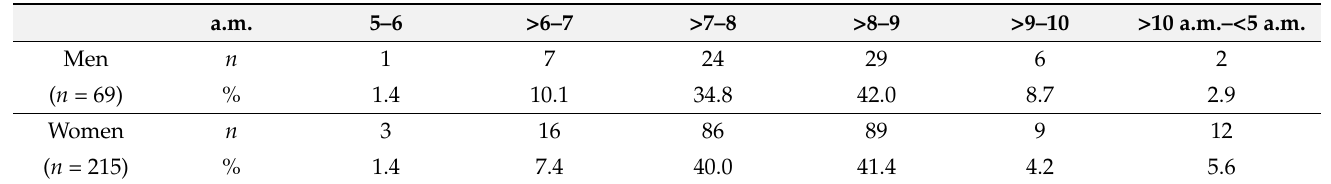
Table A2. The distribution of time when commuting from home to the place of work or study ( n participants and percentage within each sex).